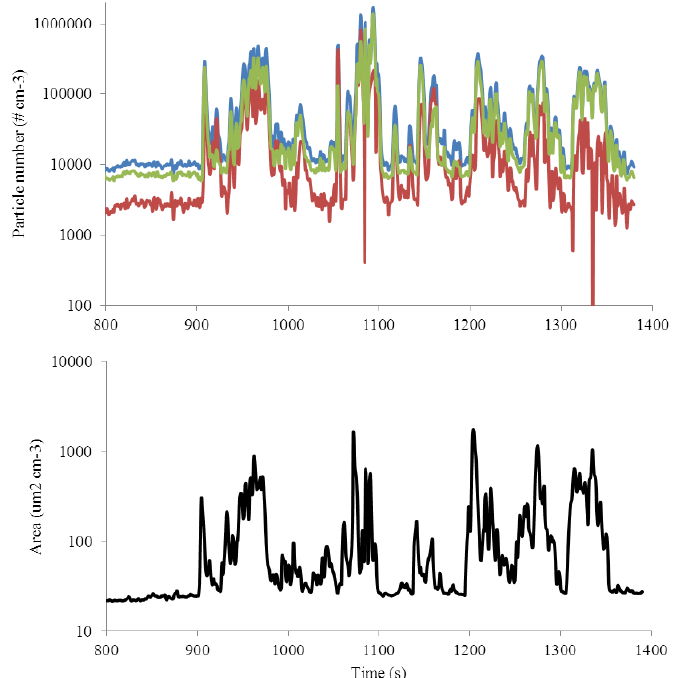
Figure 1. Performance of the three investigated modes (6–560 nm blue line, 5.6–16 nm red line, 19–560 nm green line) ( a ) and the particle surface area ( b ) during the Sn-Pb micro-welding